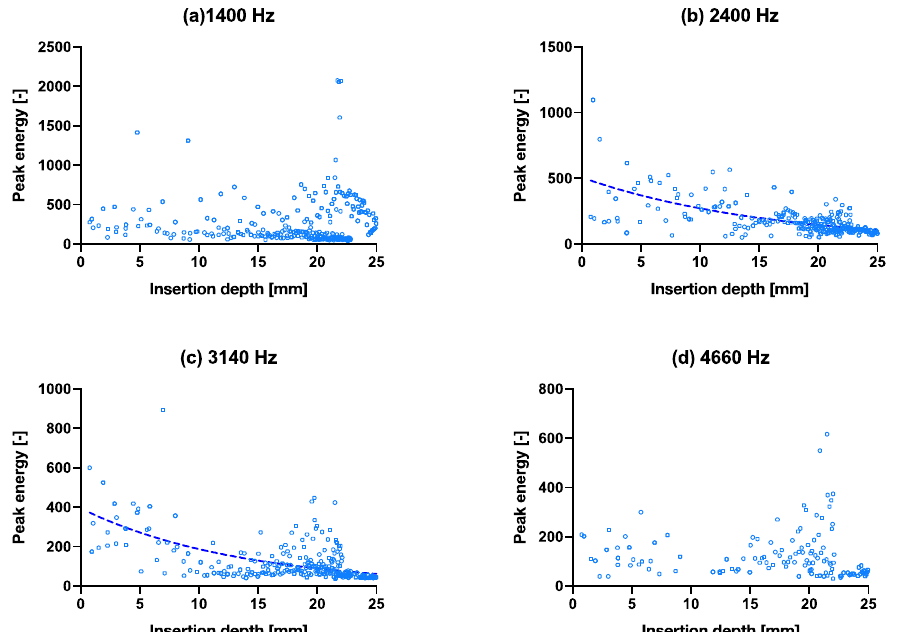
Figure 6. ( a – d ) are the isolated peak energies of each hammer blow, plotted as peak energy vs. insertion depth (fractured bone model condition) for the four main peak frequencies at 1400 Hz, 2400 Hz, 3140 Hz and 4660 Hz, respectively, with exponential trend lines. The same graphs with hammer blows on the x -axis are shown in Supplementary Materials Figure S5.